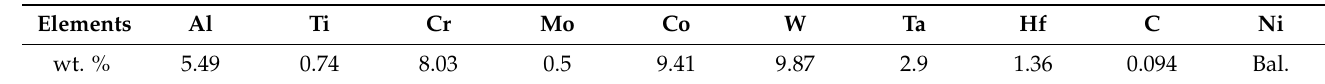
Table 1. The chemical composition of the superalloy CM247LC (wt. %).